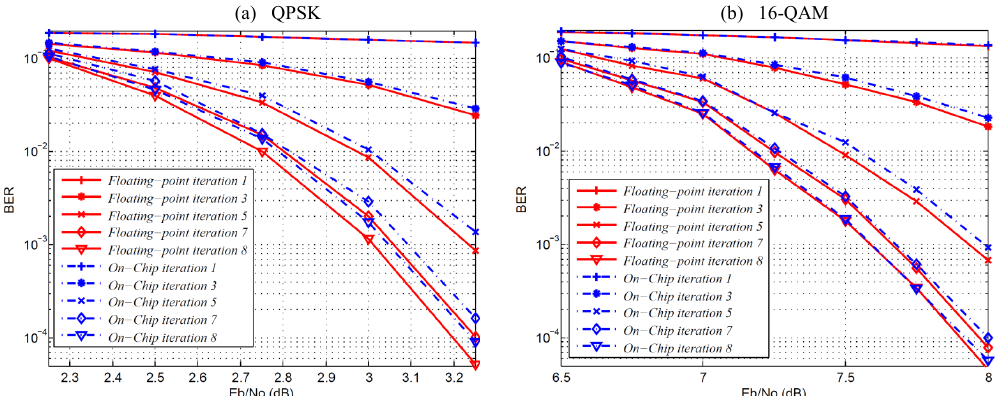
Figure 17. Comparison between the simulated reference BER and measured BER after on-chip evaluation of the designed demapper for for 1536 source bits, a 1 fading Rayleigh channel.